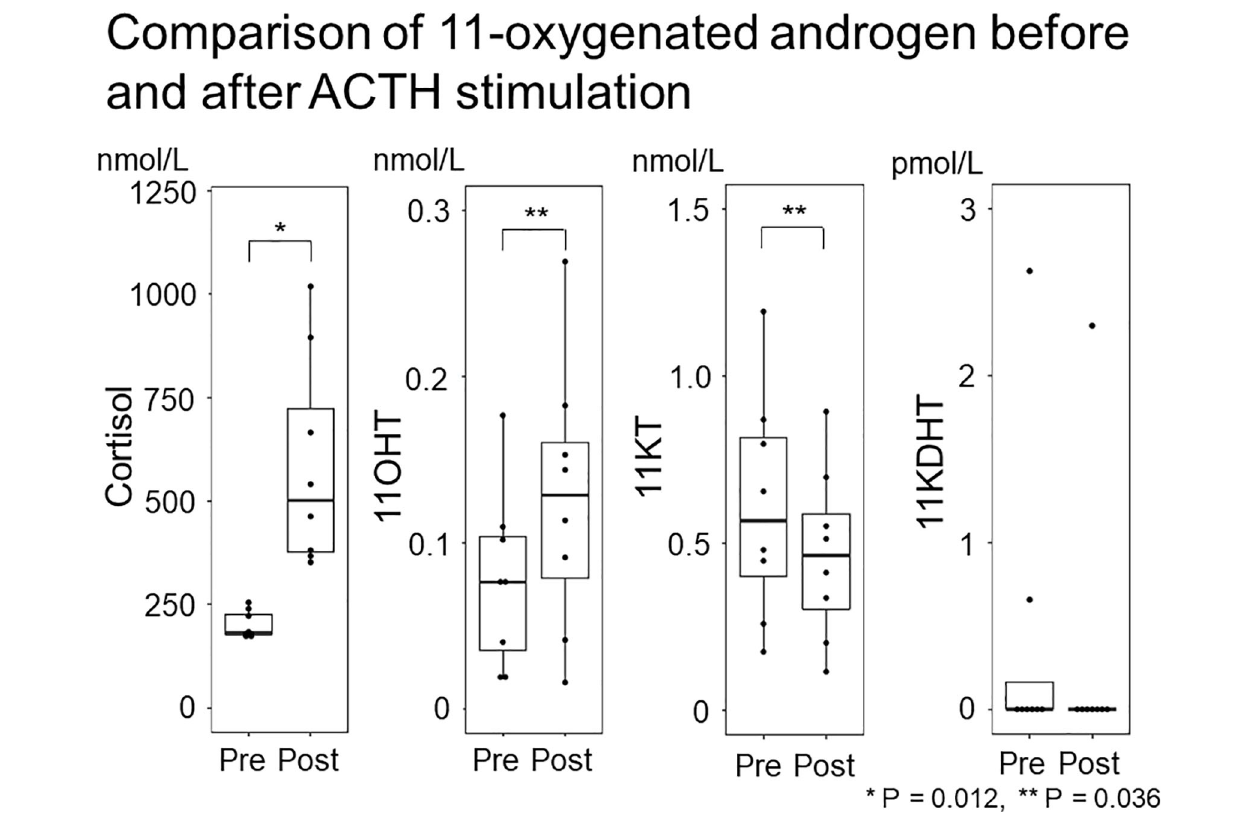
FIGURE 5 Comparison of 11-oxygenated androgen before and after ACTH stimulation. The 11-oxygenated androgen values before and after ACTH stimulation were compared. Serum cortisol and 11OHT were higher after ACTH stimulation, but 11KT did not differ before or after ACTH